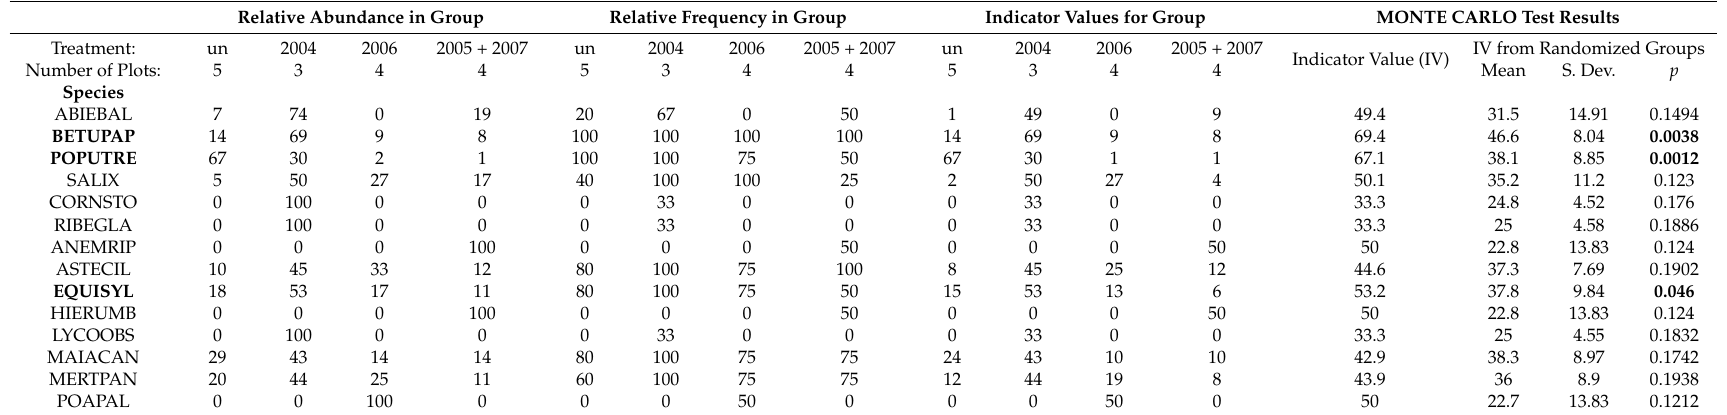
Table 4. Summary of results from indicator species analysis including only species with p < 0.2 for Monte Carlo test results. Full species names are provided